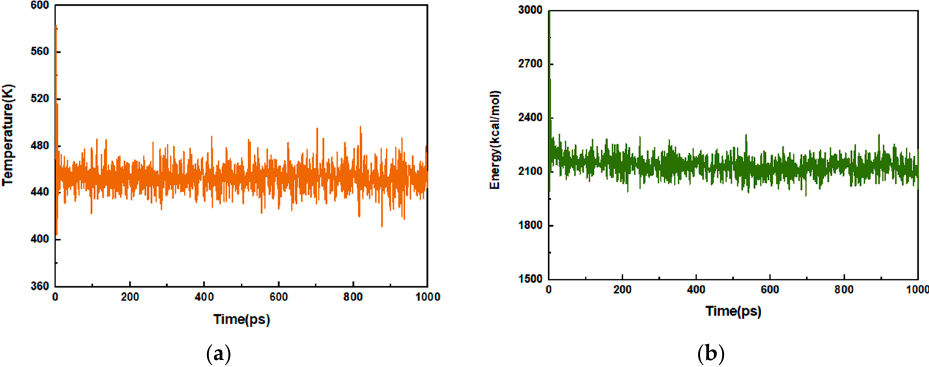
Figure 2. Temperature and energy fluctuations of the system: ( a ) Temperature–Time; ( b ) Energy–Time.